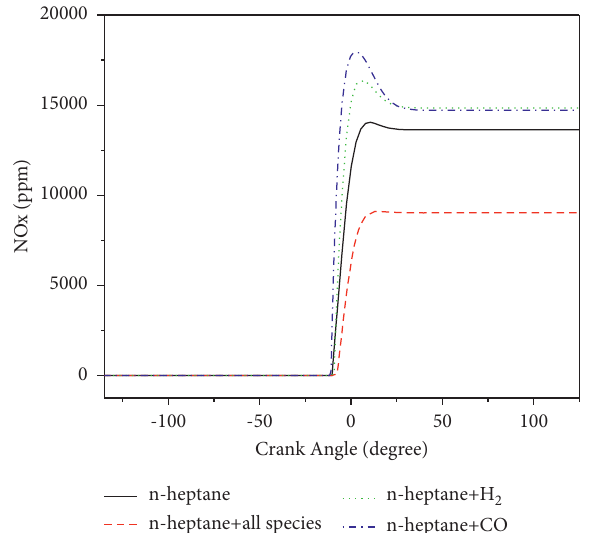
Figure 14: Effects of different reforming species on NOx emissions from the normal cylinder.